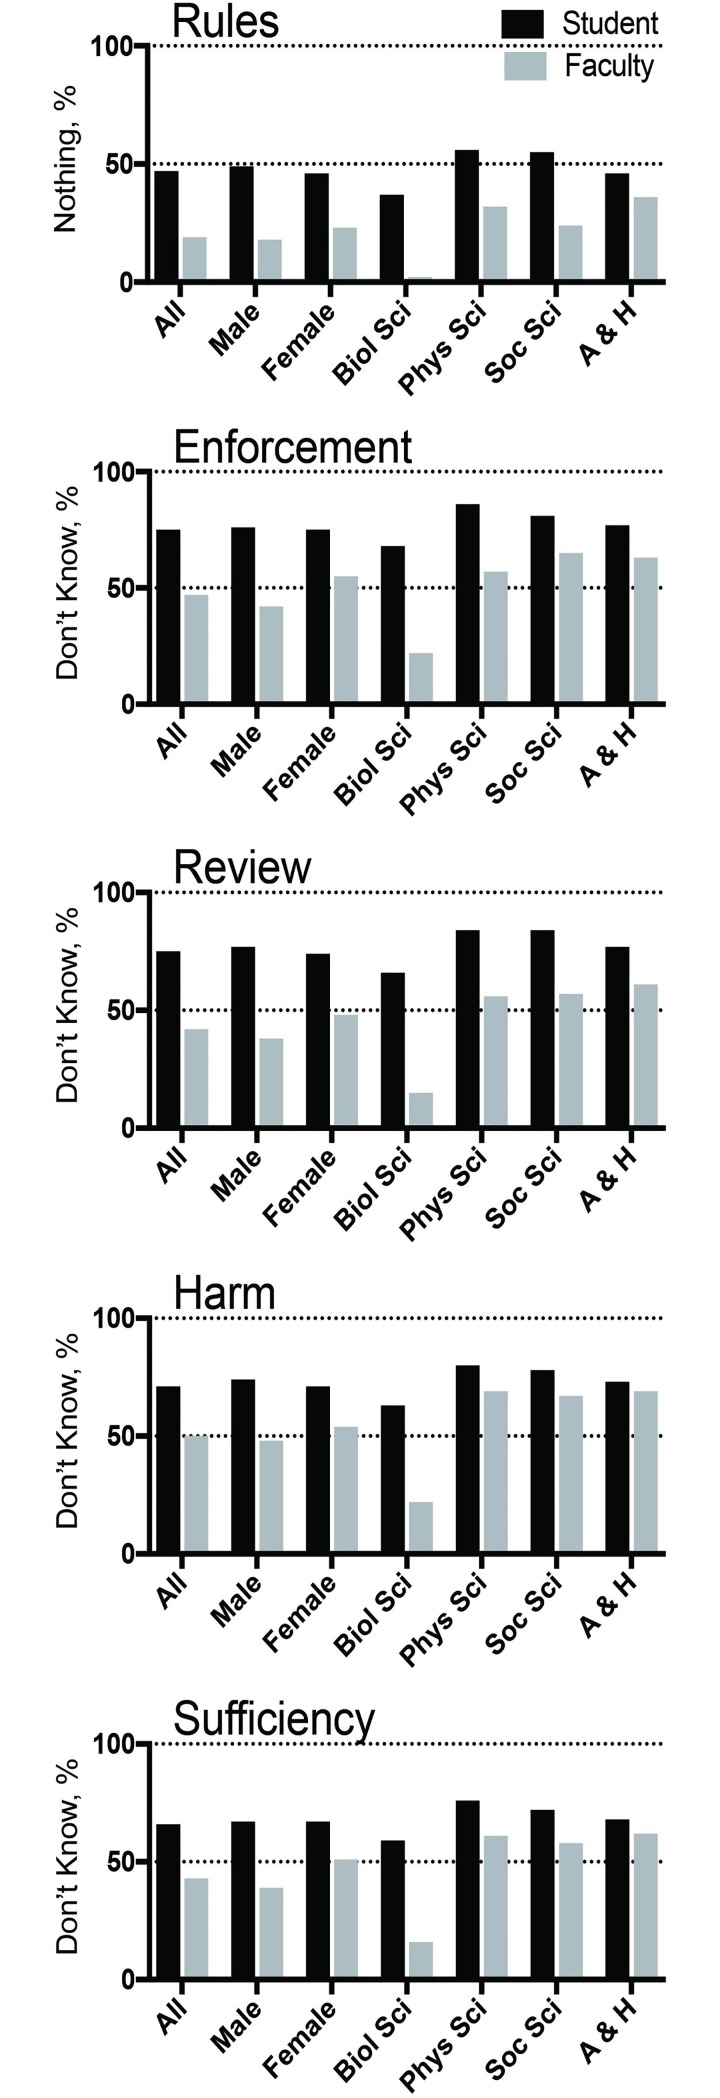
Percent of respondents answering “Nothing” about knowledge of rules and regulations, and “Don’t know” about adequacy of enforcement of laws, review of proposals, minimizing harm, and sufficiency of rules.